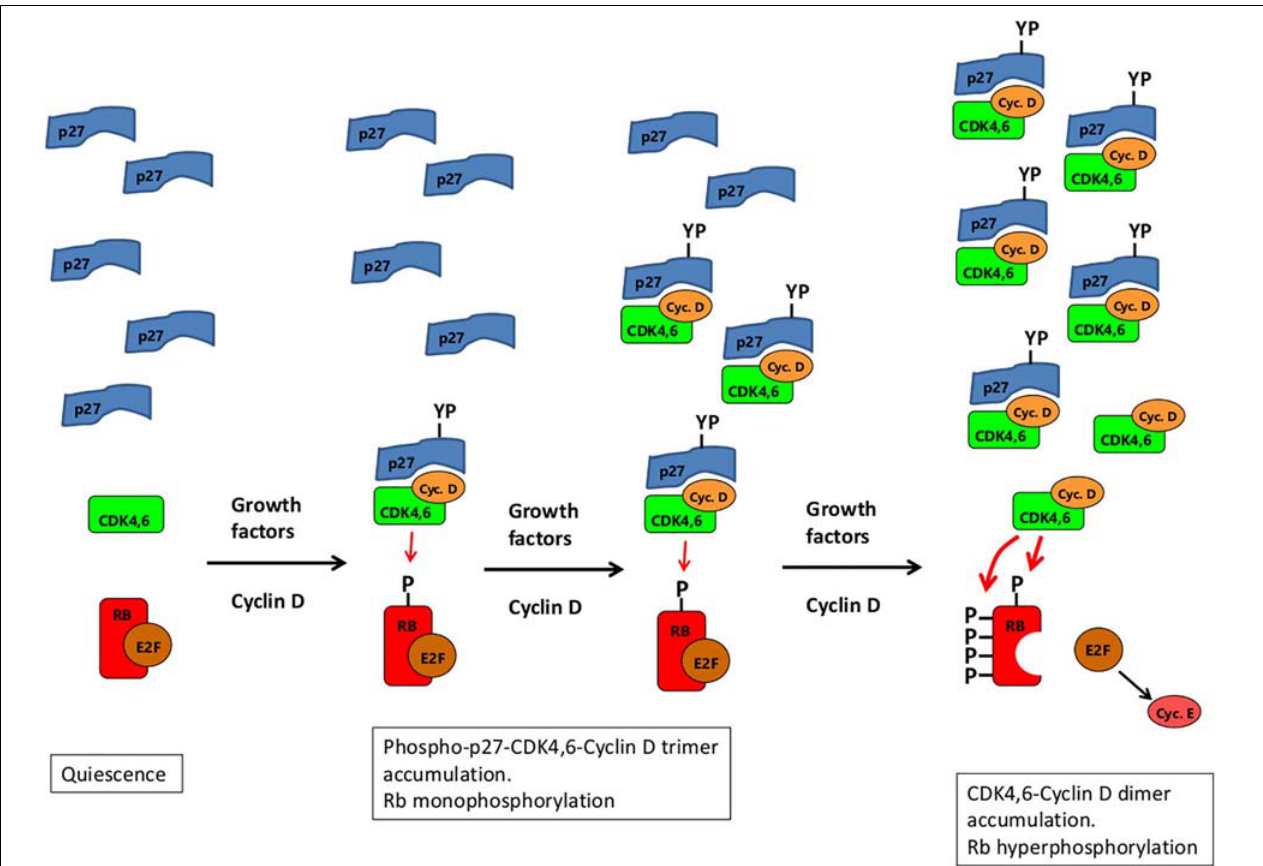
FIGURE 3 | A schematic illustrating a possible explanation of both RB-monophosphorylation and RB-hyperphosphorylation by CDK4,6/cyclin D. Growth factor stimulation of quiescent cells leads the expression of Cyclin D, which complexes with CDK4,6 and p27. The trimer, when phosphorylated on Tyr74 of p27 (marked YP) is a weak kinase for RB (resistant to palbociclib), enabling monophosphorylation of RB. (Whether tyrosine phosphorylation of p27 is restricted to the trimer or applies equally to the monomer, is not known. The lack of p27 monomers marked with YP in the diagram should not be taken therefore to imply that phosphorylation of the monomer does not occur.) As cyclin D expression continues, more and more of the trimer accumulates, eventually sequestering all the p27 monomers. From then on, further production of cyclin D leads to fully active CDK4,6/cyclin D dimers (sensitive to palbociclib) that hyperphosphorylate Rb. The derepressed E2F then induces expression of cyclin E which, together with CDK2, sustains Rb hyperphosphorylation thereafter.